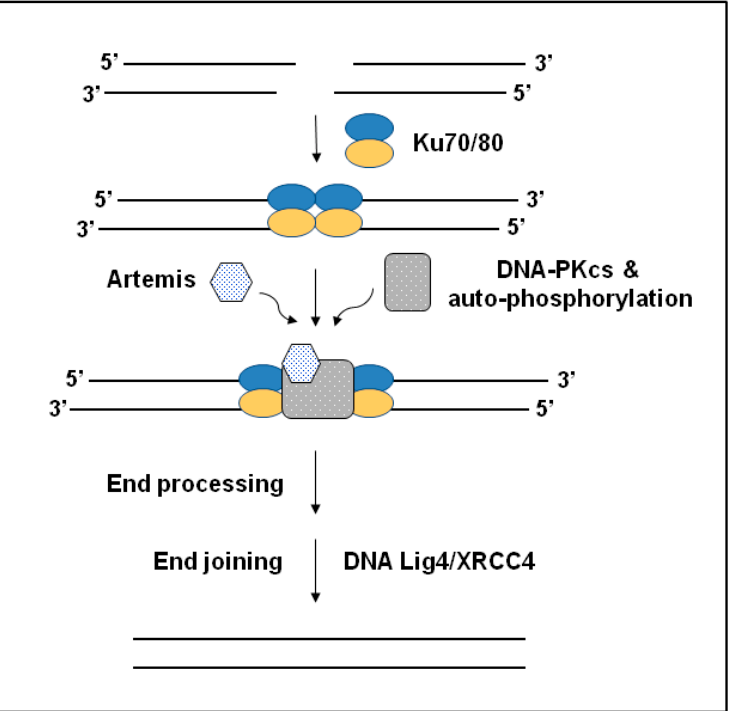
Figure 2. Schematic representation of nonhomologous end-joining (NHEJ) repair pathway in mammalian cells. The scheme shows that following a DSB, Ku which has a high affinity to DNA ends binds to the DNA. This binding causes conformational changes allowing the DNA-PKcs to bind. Ku can also act as an alignment factor for NHEJ accuracy. Upon the formation of the DNA-PK assembly on DNA breaks, this complex causes activation of the serine/threonine protein kinase, and target substrates such as Artemis get phosphorylated, colocalizing at the ends of the broken DNA before end ‐ processing and end ‐ joining events [55].